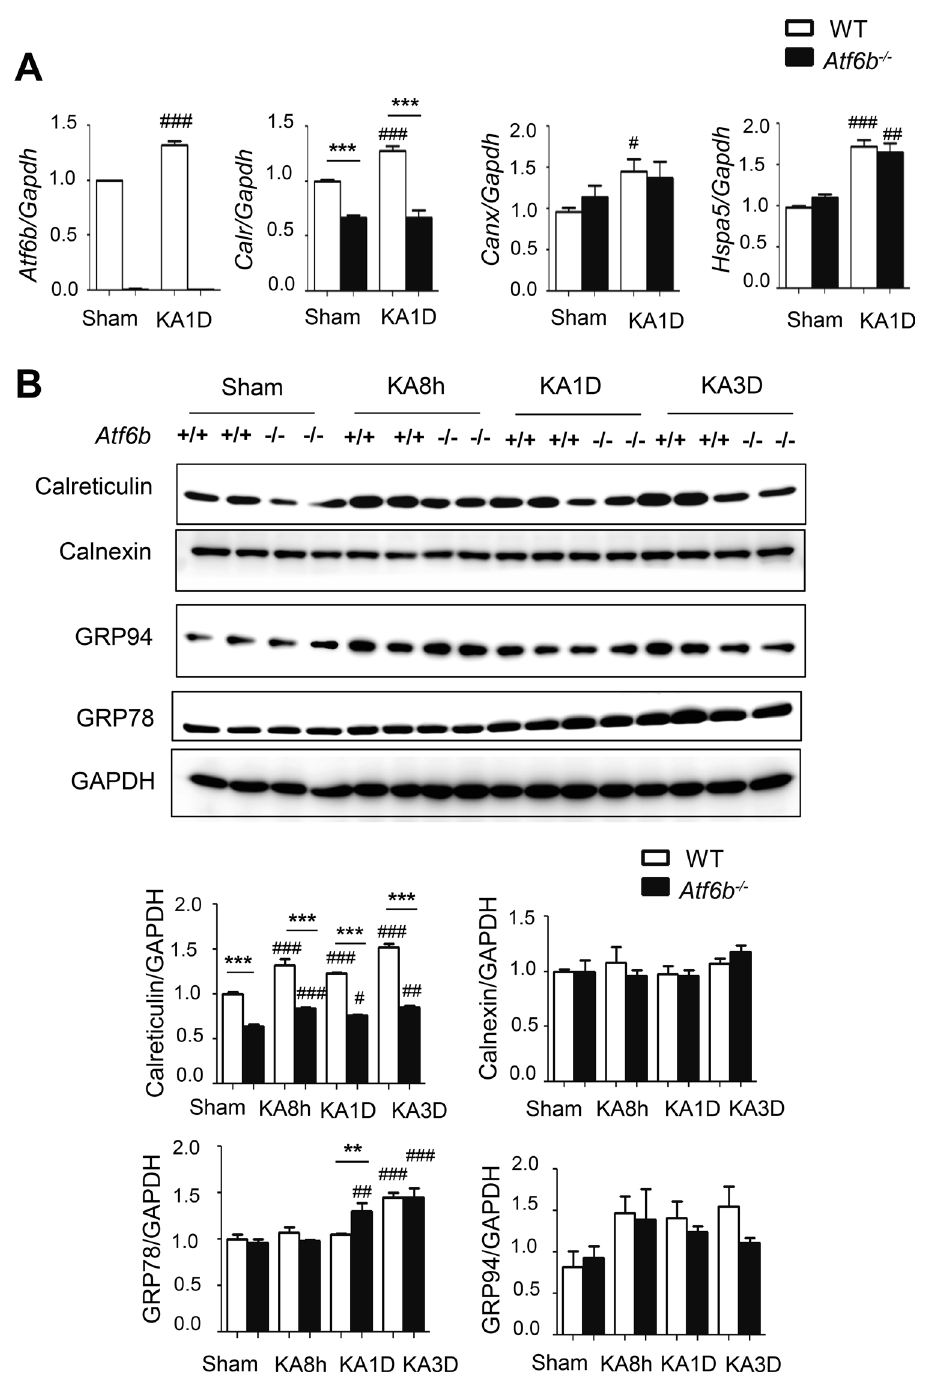
Figure 6. Expression of molecular chaperones in the ER in KA-injected mice. ( A ) Total RNA was isolated from the CA3 region of hippocampi from KA-injected WT and Atf6b −/− mice and qRT-PCR was performed. n = 4 mice. Data are shown as mean ± SEM. ***p < 0.001 between two genotypes and # p < 0.05, ## p < 0.01, ### p < 0.001 compared to normal conditions by a two-way ANOVA followed by the Bonferroni test. ( B ) Protein samples were extracted from the CA3 region of hippocampi from KA-injected WT and Atf6b −/− mice and subjected to western blotting using antibodies against CRT, calnexin, GRP94 and GRP78. n = 4–5 mice. Data are shown as mean ± SEM. **p < 0.001, ***p < 0.001 between two genotypes and # p < 0.05, ## p < 0.01, ### p < 0.001 compared to normal conditions by a two-way ANOVA followed by the Bonferroni